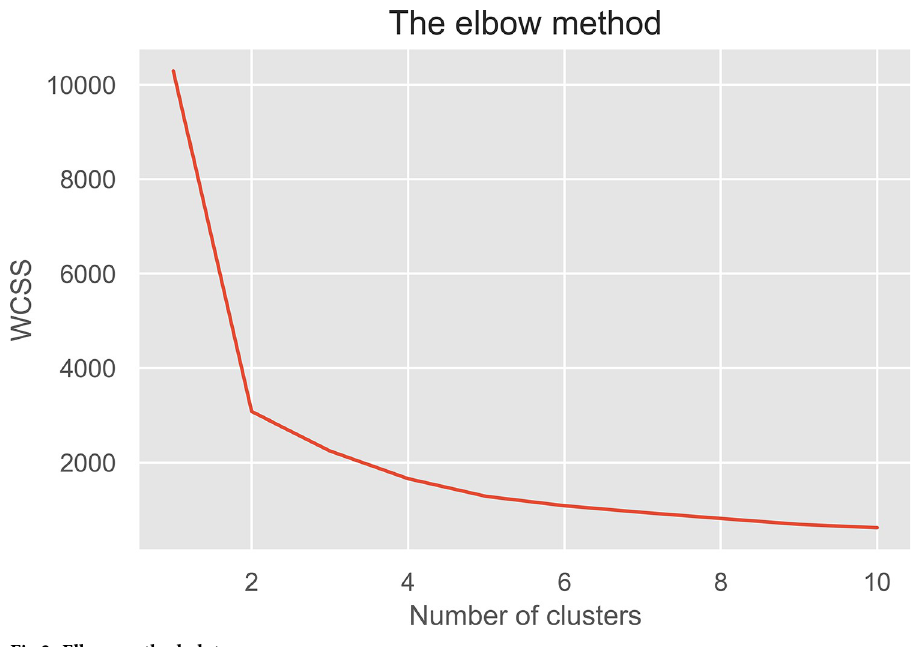
Fig 2. Elbow method